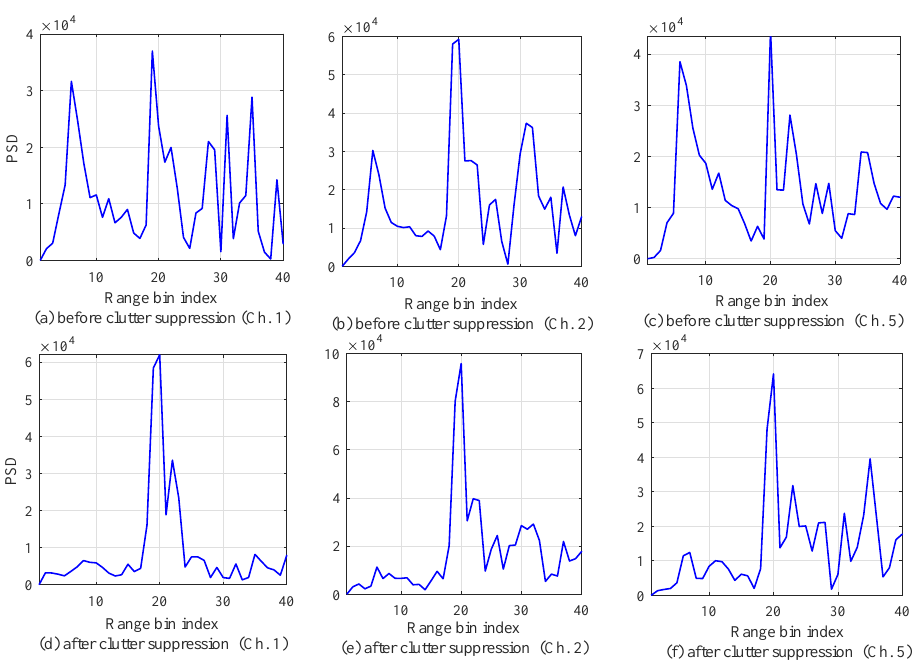
Figure 15. Experiment results of range detection from multiple channels. ( a ) Before clutter suppression with Ch. 1; ( b ) after clutter suppression (Ch. 1); ( c ) before clutter suppression (Ch. 2); ( d ) after clutter suppression (Ch. 2); ( e ) before clutter suppression (Ch. 5); ( f ) after clutter suppression (Ch. 5).